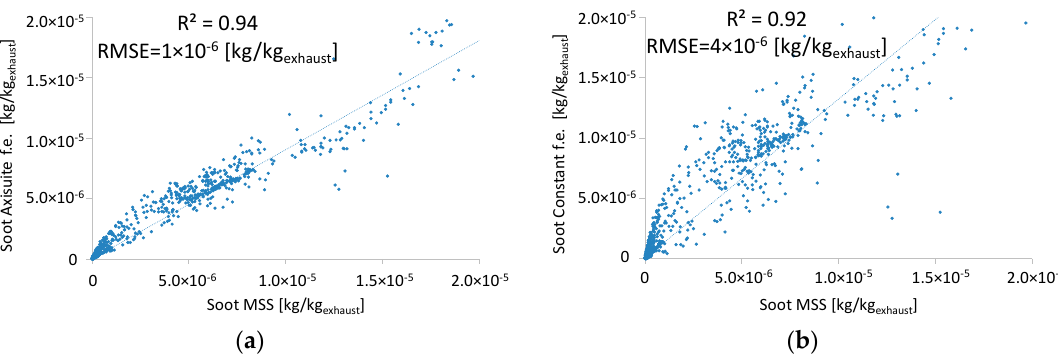
Figure 14. Modeled DPF filtration efficiency ( a ) calculated by Axisuite and ( b ) as a constant value. Improved performance of the advanced model compared to the constant filtration efficiency based on R 2 and root mean square errors (RMSE) values. Table 5. DPF model’s variables and associated errors.